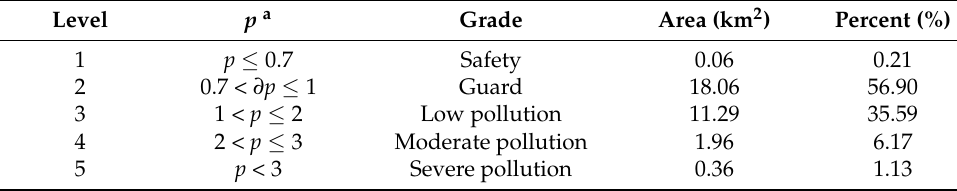
Figure 9. Spatial distributions of metals in farmland soils. Table 4. The evaluation standard and results in study